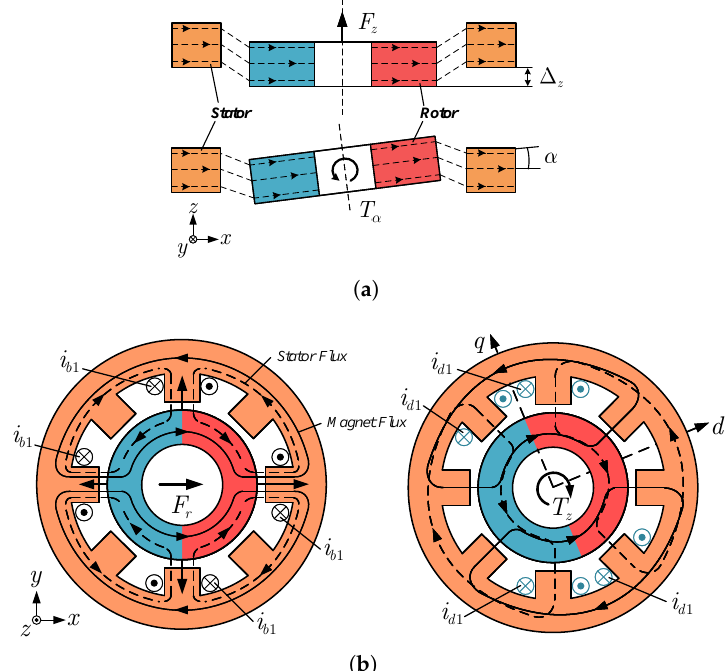
Figure 1. ( a ) A stabilizing axial reluctance force F z and restoring torque T α caused by a rotor deflection in the z -axis direction and tilting around the axis perpendicular to the direction of magnetization, respectively. ( b ) Active suspension force and torque